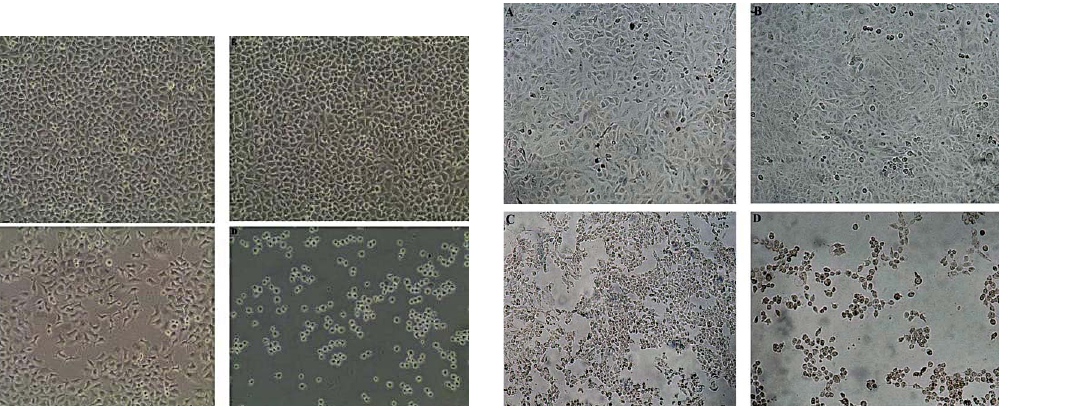
Fig. 4. Graph representing Vero cell cytotoxicity of Phomopsis sp., crude endophytic fungal Ethyl acetate extract.